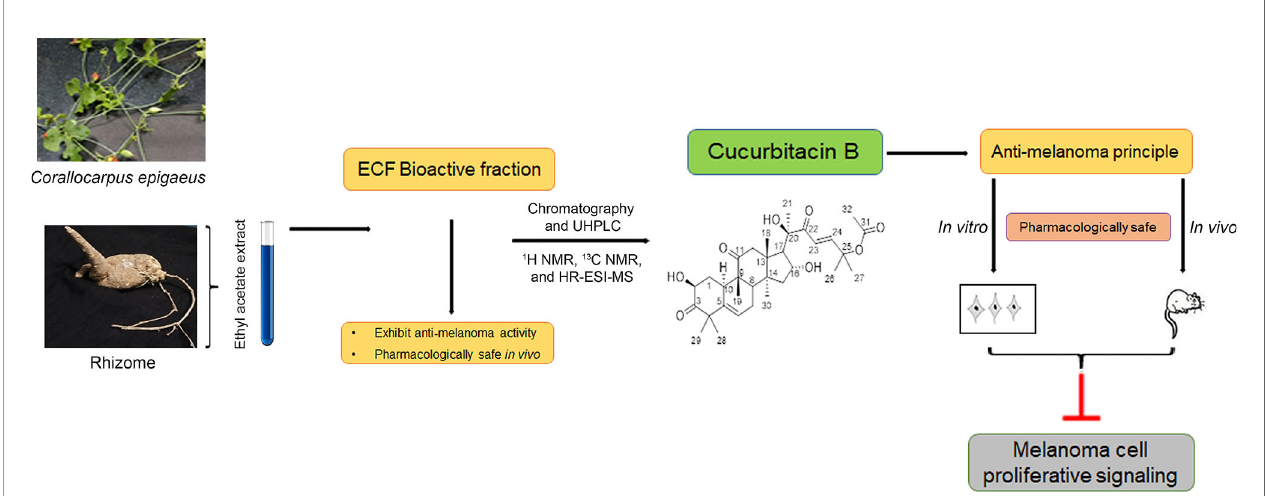
FIGURE 6 | Schematic representation highlighting the isolation process and characterization of the anti-melanoma principle, Cucurbitacin B from the rhizome of C . epigaeus . Brie fl y, ethyl acetate extract of C. epigaeus rhizome, was fractionated using column chromatography, which yielded puri fi ed Cu-B and the isolated anti- cancer principle was characterized and veri fi ed using 1 H NMR, 13 C NMR and HR-ESI-MS analysis. In vitro and in vivo studies validated the potential of Cu-B to attenuate melanoma by targeting critical proliferative signals. The pharmacological safety of ECF and ECF-derived Cu-B were assured in Swiss albino